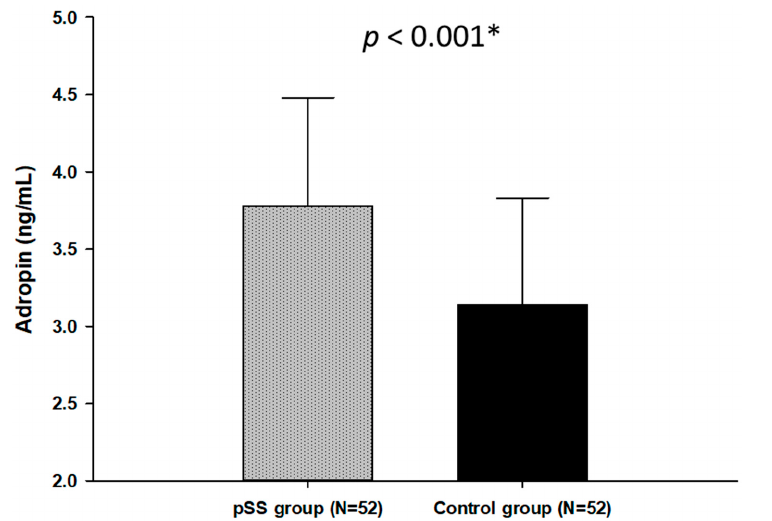
Figure 1. Plasma adropin levels in the pSS group and the control group. Data are presented as mean ± standard deviation. * t -test for independent samples. Table 3. Characteristics of primary Sjögren’s syndrome patients based on adropin level.